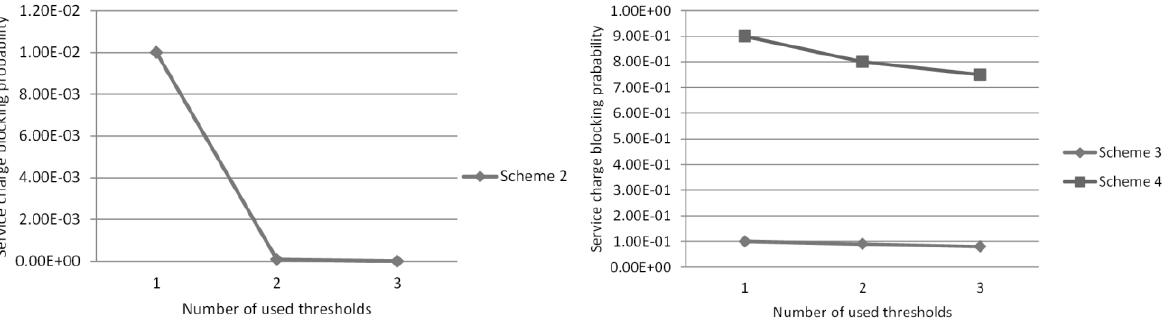
Figure 8. Effect of changing the number of thresholds on the service charge blocking probability of different CQoS schemes when fixing the service load of scheme 1 at 0.15 E and the total service load at 0.65 E . p